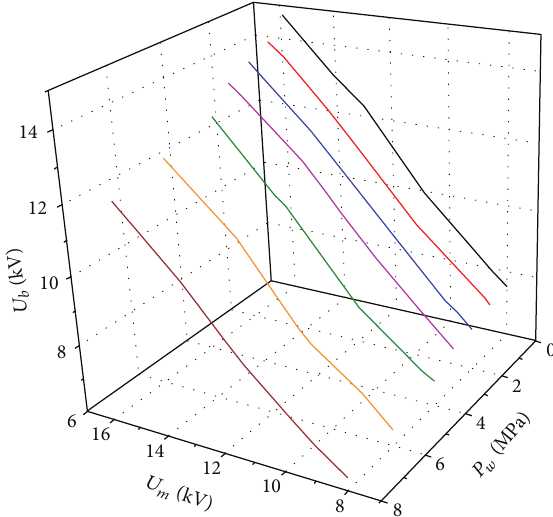
Figure 4: Time-history curve of discharge current 𝐼(𝑡) .